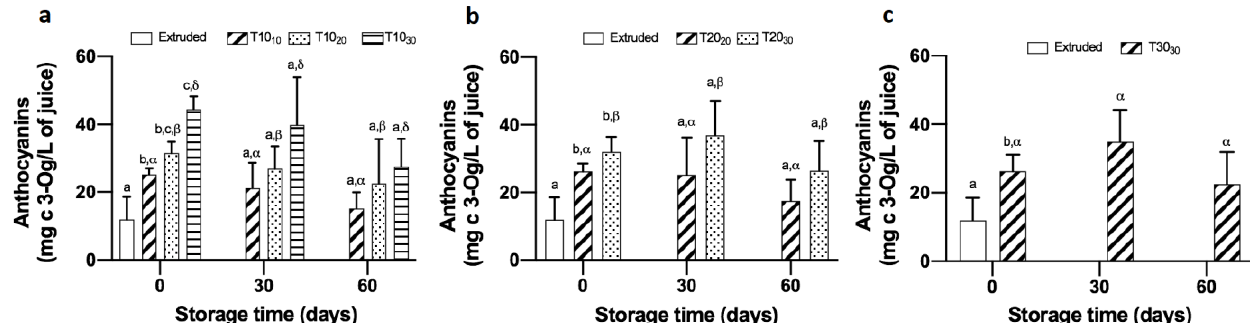
Figure 2. Total anthocyanin content of Pa í s grape juices at different initial extraction times determined by pH differential assay, before and after 30 and 60 days of storage, where ( a ) is for juice samples collected at 10 min of the run at which sampling started (T10 10 , T10 20 , T10 30 ); ( b ) is for juice samples collected at 20 min of the run at which sampling started (T20 20 , T20 30 ) and ( c ) is for juice samples collect-ed at 30 min of the run at which sampling started (T30 30 ). The columns with different lowercase letters for the same storage time are significantly different at p < 0.05 based on Tukey’s test in the case of the T10 samples and Student’s test in the case of the T20 and T30 samples. The columns with different symbols ( α , β , δ ) for the same initial extraction time and different storage times are significantly different at p < 0.05 based on Tukey’s test.